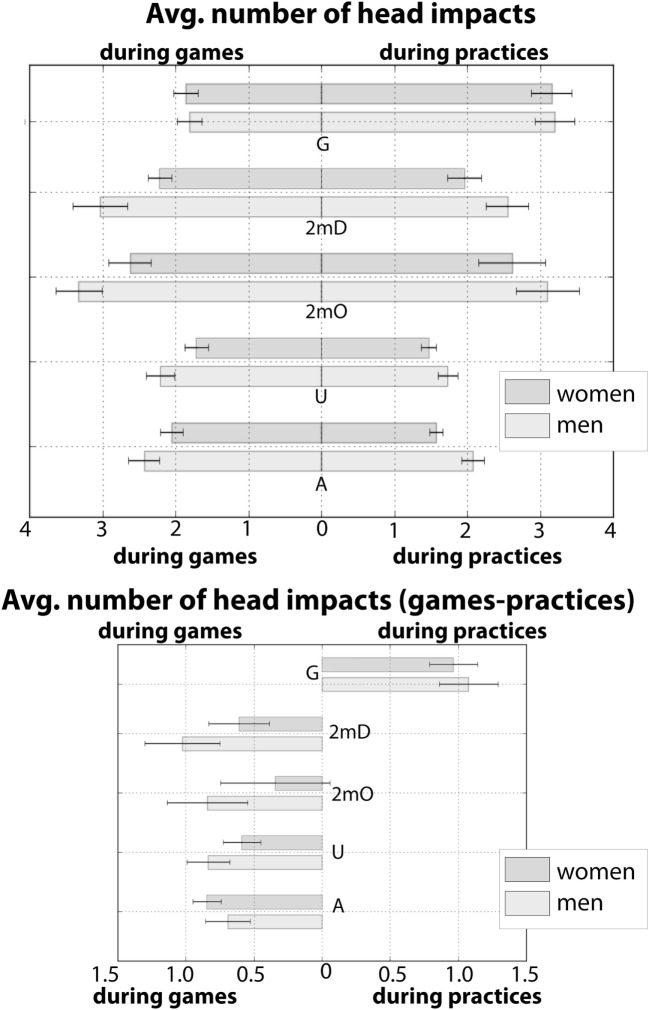
Average number of reported head impacts during a “typical game” and a “typical practice” for men and women. In the top bar graph, position is presented on the y-axis. The leftward pointing bars left indicated the average number of blows reported during a “typical game” and rightward pointing bars indicate indicated the average number of blows reported during a “typical practice.” The bottom bar plot is the subtraction (game-practice) of the leftward and rightward pointing bars from the top plot. All positions except for goalies report more head impacts during games. Error bars reflect the SE of the mean.